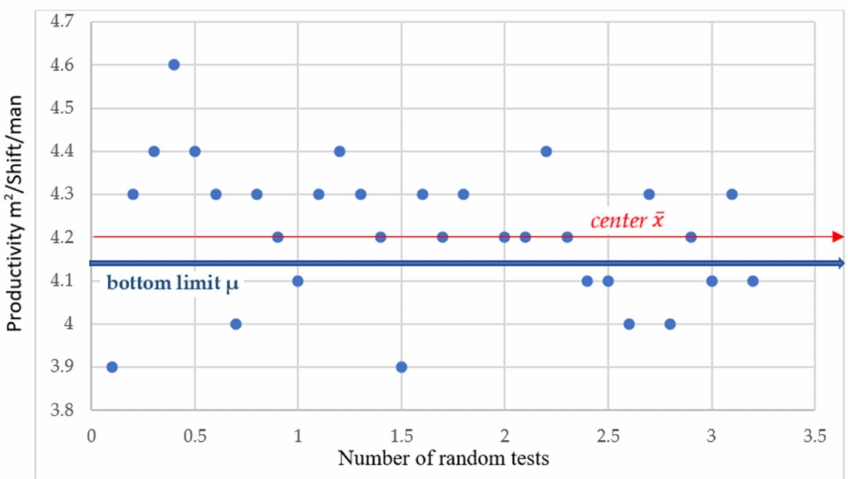
Figure 12. Graphic illustration of the tiling works performances including the mean